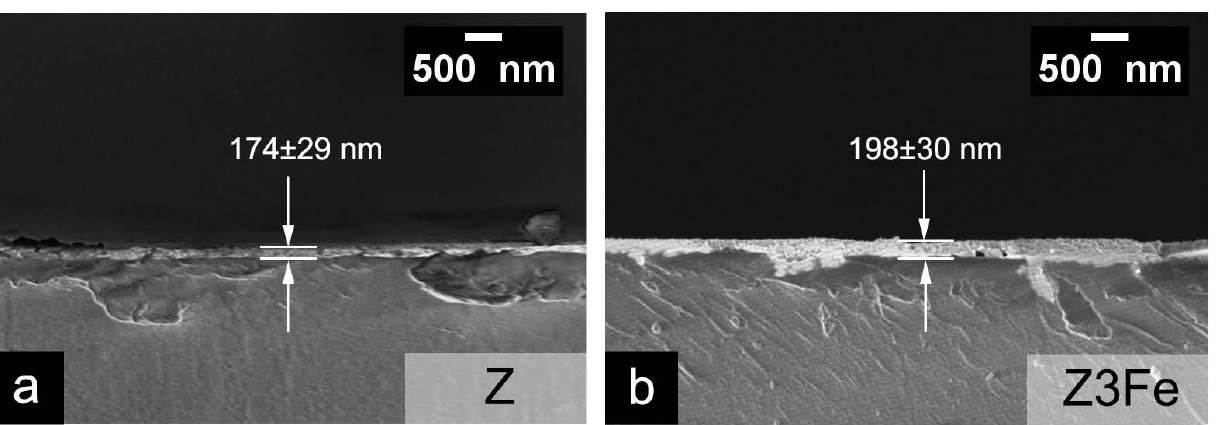
(b) films applied. The calculated film thickness values for Z, Z1Fe, Z2FE, and Z3Fe were 174 ± 29, 181 ± 11, 185 ± 40, and 198 ± 30 nm, respectively Thus, the thickness of the thin film increases with increasing Fe2O3 sputtering time.